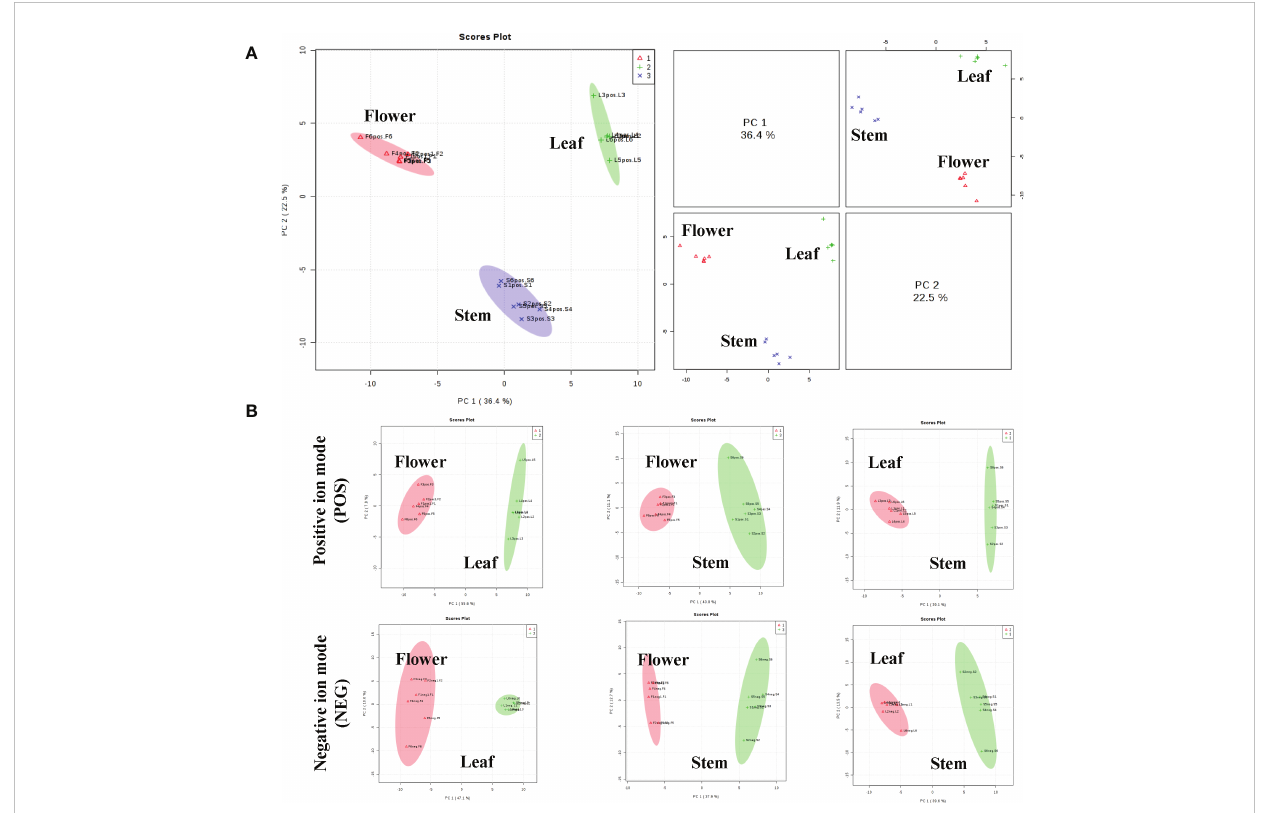
FIGURE 2 The principal component analysis (PCA) scatter plots between the three tissues of P. cablin . (A) PCA scatter plot of leaf (green circle), stem (blue circle) and fl ower (red circle) in positive ion mode (POS). (B) The PCA between any two tissues in P. cablin in positive and negative ion modes, respectively. The PCA was depends on the LC-MS data from all groups in positive and negative ion